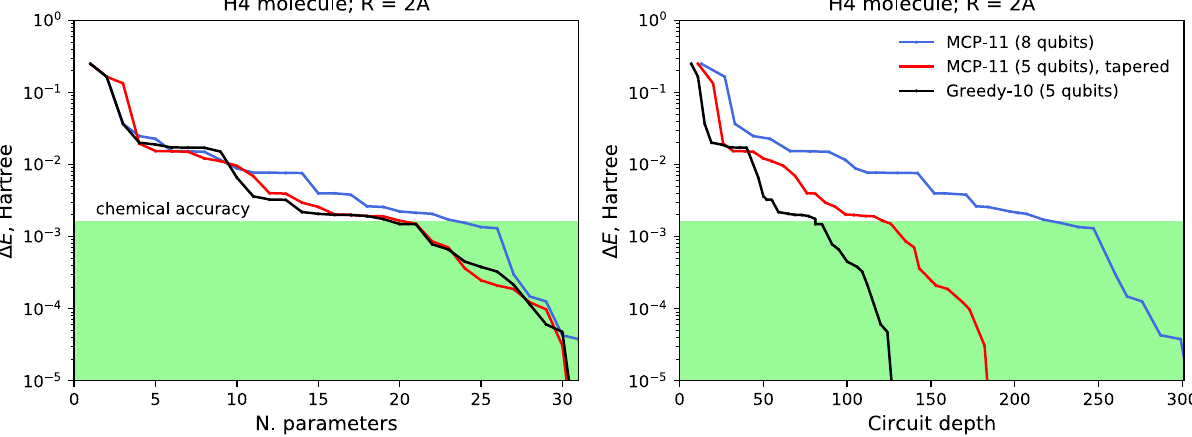
Fig. 3 Qubit ADAPT-VQE convergence of energy with respect to the number of parameters and the circuit depth for H 4 molecule. The results are provided at molecular radius R equal 2.0 angstrom (Å). Δ E is the energy difference with the exact ground state energy in Hartree. MCP-11 is the minimal complete pool acting in the original qubit space of 8 qubits suggested in Ref. 29 . `MCP-11, tapered' is built from MCP-11 by applying tapering procedure. Greedy-10 pool is a qubit linear complete pool constructed using the computational scheme proposed in this work and acts in a 5-qubit